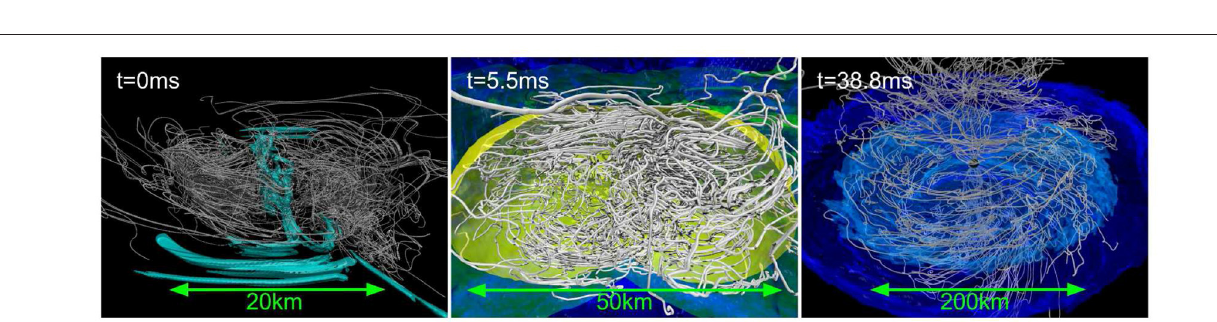
FIGURE 6 | NS rest-mass density ρ 0 (upper left rainbow colorbar) and magnetic field (lower left brownish colorbar) on the orbital plane at t = 10.0ms following an NSNS merger at three different resolutions [ 1 x = 147m (left) , at 1 x = 74m (middle) , and 1 x = 37m (right) ]. The initial magnetic field strength is 5 × 10 11 G (adapted from Aguilera-Miret et al., 2020).